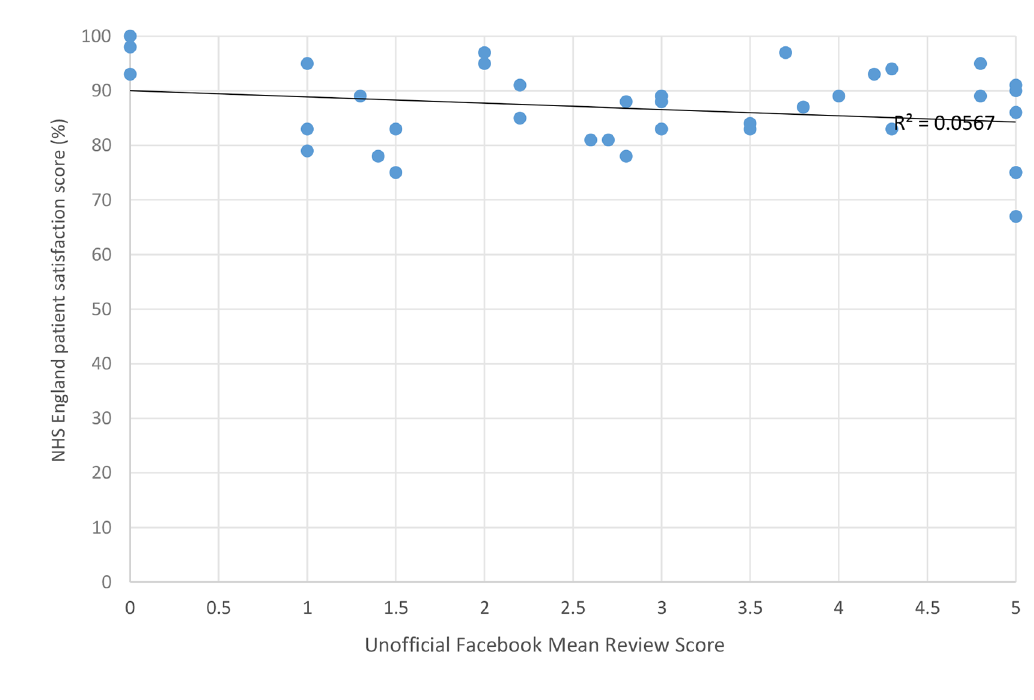
Figure 3. NHS England Patient Satisfaction score (%) versus unofficial Facebook review